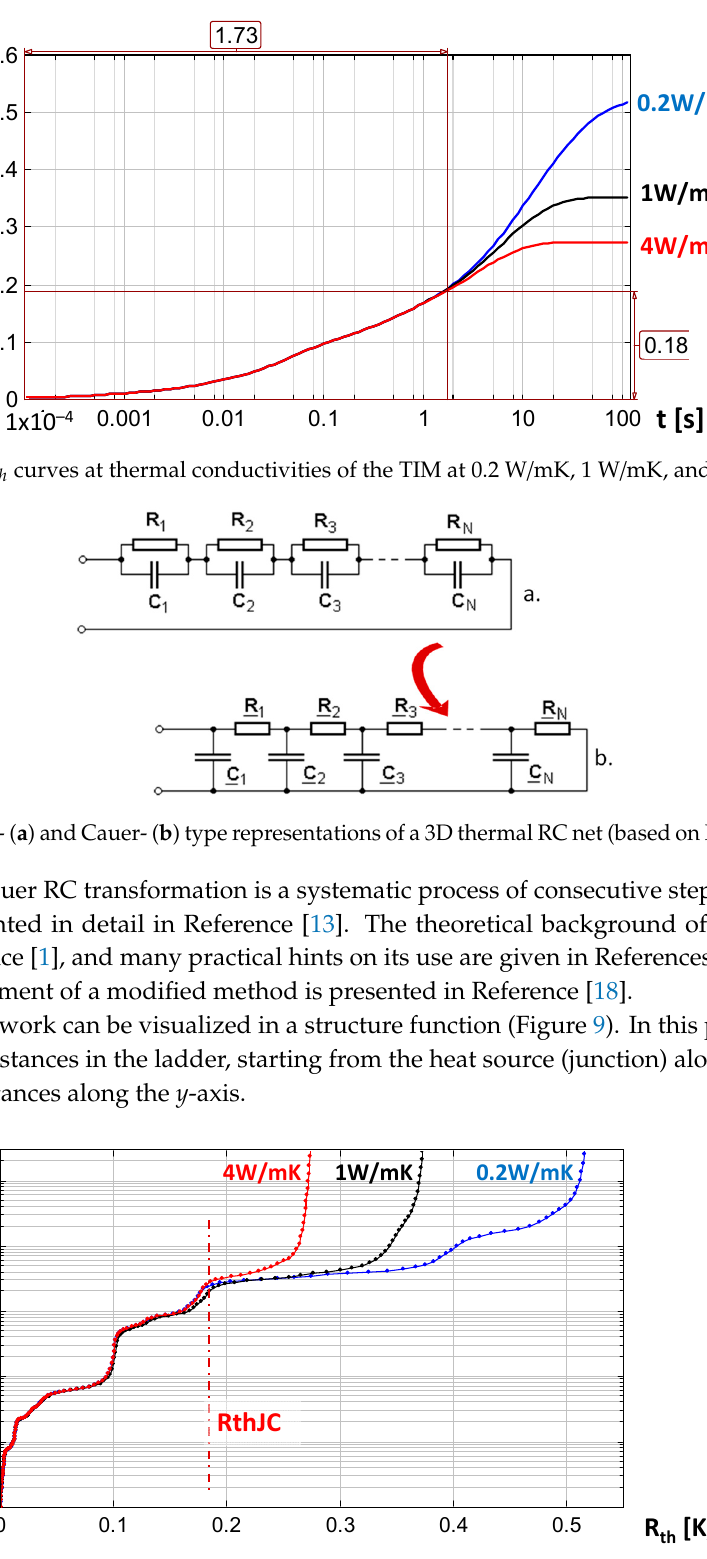
Figure 9. Structure functions with thermal conductivities of the TIM at 0.2 W/mK, 1 W/mK, and 4 W/mK. Junction to case thermal resistance is shown.